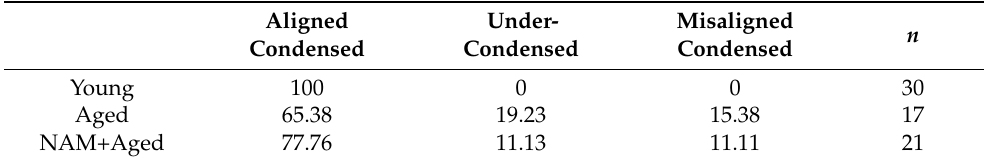
Figure 2. Chromosomal abnormalities in aged oocytes and the decreased germ cell apoptosis level in an aged mother are improved by nicotinamide (NAM) supplementation in Caenorhabditis elegans : ( A ) Schematic illustration of oocytes in the C. elegans hermaphrodite germline. Chromosomal aberrations were observed by DNA staining in young, aged, and NAM+aged at -1 oocytes. The type of aberration was classified into three categories: (1) aligned and condensed chromosomes, (2) undercondensed chromosomes, and 3) misaligned and condensed chromosomes. The percent distributions of the respective categories in young, aged, and NAM+aged oocytes are presented; ( B ) Schematic illustration of each zone in C. elegans germline. Representative images of the RAD-51 foci (green) in the late pachytene region are shown. The numbers of RAD-51 foci per germ nucleus in each group are shown (each condition, n = 30). Error bars represent standard deviation (SD). *, p < 0.05, **, p < 0.01 (two-way ANOVA with Tukey’s post hoc test); ( C ) Average numbers of acridine orange (AO)-positive germ cells per gonad arm in non-treated (0 mM) or NAM-treated (1 mM) hermaphrodites with age. Error bars represent SD. n.s., not significant, *, p < 0.05 (two-way ANOVA with Tukey’s post hoc test); ( D ) Western blot analysis of CED-4 and CED-9 protein levels using anti-CED-4 and anti-CED-9 antibodies in each condition. α -tubulin was used as a loading control. Relative expression levels of CED-4 and CED-9 in each condition are shown. CED-4 or CED-9 band intensity was normalized to that of α -tubulin on the same lane, and the relative levels of CED-4 and CED-9 were converted to a relative value against that of the young mothers as 1. Error bars represent SD. n.s., not significant, *, p < 0.05 (two-way ANOVA with Tukey’s post hoc test); (E) The percentage of embryonic lethality among the total number of progenies produced by either aged wild-type (WT) N2 or aged ced-3 mutants supplemented with or without 1 mM NAM. Error bars represent SD. *, p < 0.05, n.s., not significant (two-way ANOVA with Tukey’s post hoc test). Table 1. Chromosome morphology at -1 oocyte